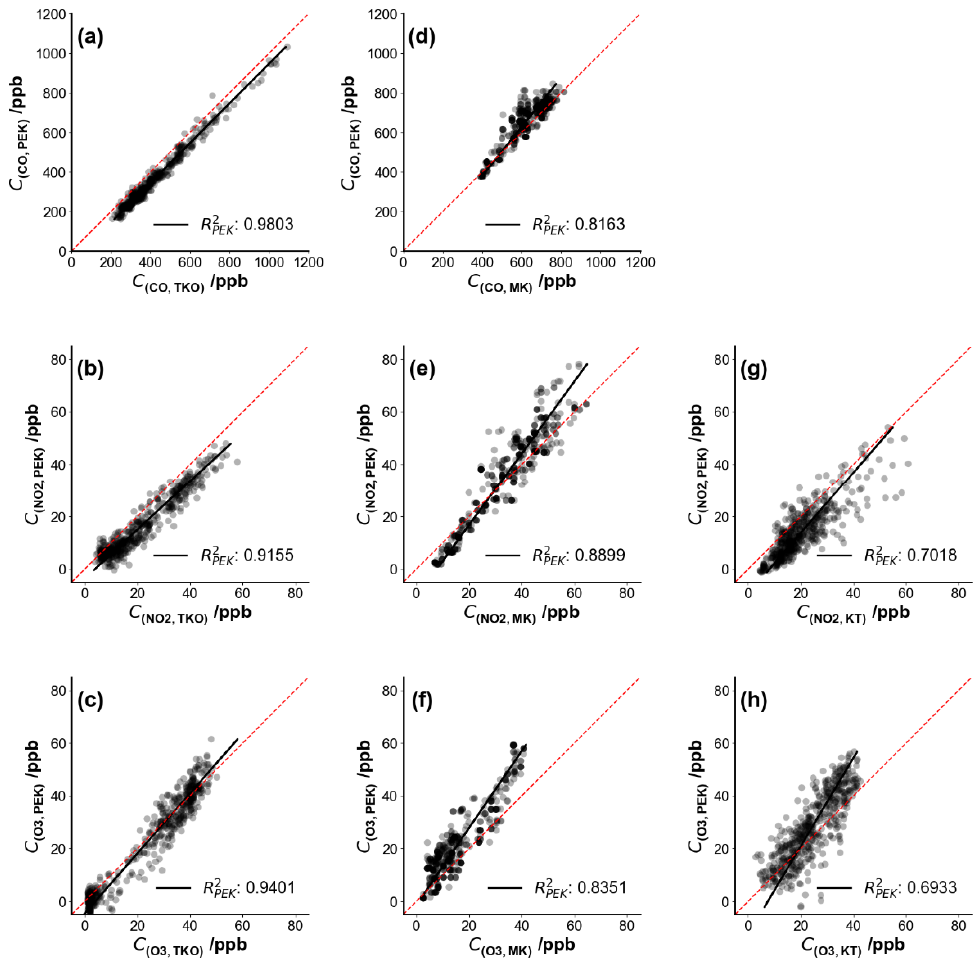
Figure 7. Scatter plots of gases measured by the Personal Exposure Kit (PEK) under laboratory calibration condition (Methodology 2.3.1 (I)) against concentration values collected by fixed monitors at the reference sites. Each sub-figure corresponds to the time series plots shown in Figure 6: ( a – c ) Tseung Kwan O (TKO), ( d – f ) Mong Kok (MK) and ( g , h ) Kwun Tong (KT) air quality monitoring sites. The dashed red line represents the identity line. Data resolution is set as 5 min.